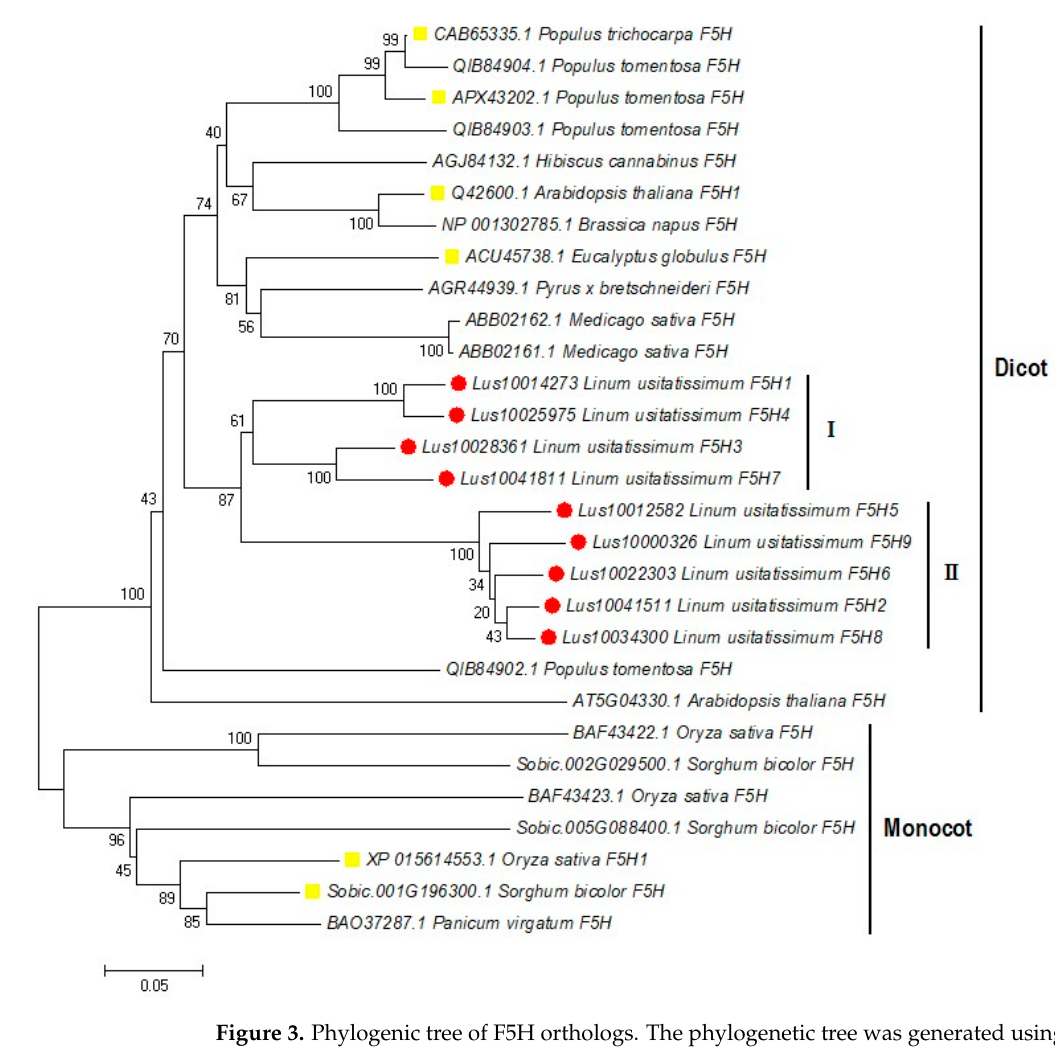
Figure 3. Phylogenic tree of F5H orthologs. The phylogenetic tree was generated using the neighbor- joining method of the Mega7 program. Bootstrap support was based on 1000 replicates. The red dots represent Linum usitatissimum F5H, and the yellow squares are genetically characterized F5H. The F5H sequences of Sorghum bicolor and Linum usitatissimum were obtained from the Phytozome database, and the other F5H sequences were downloaded from the NCBI.